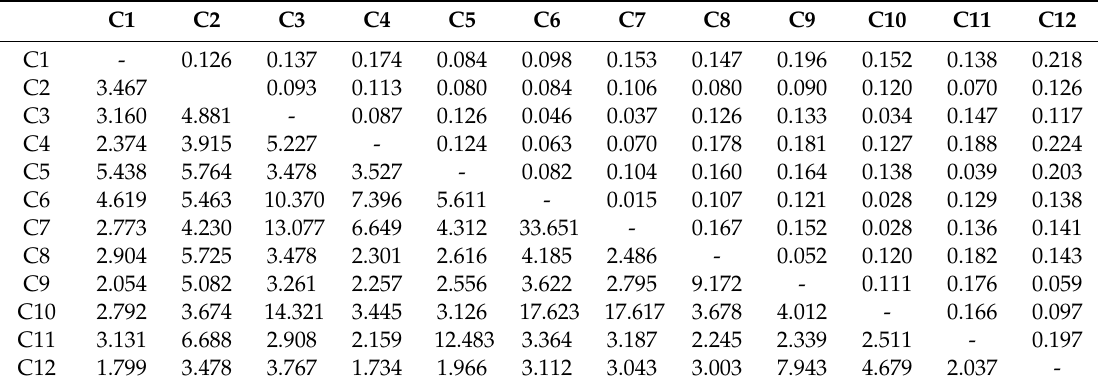
Table 6. Pairwise cluster PhiPT values (above diagonal) and Nm values based on 999 permutations (below diagonal) from AMOVA (all PhiPT values were significantly greater than 0, p <